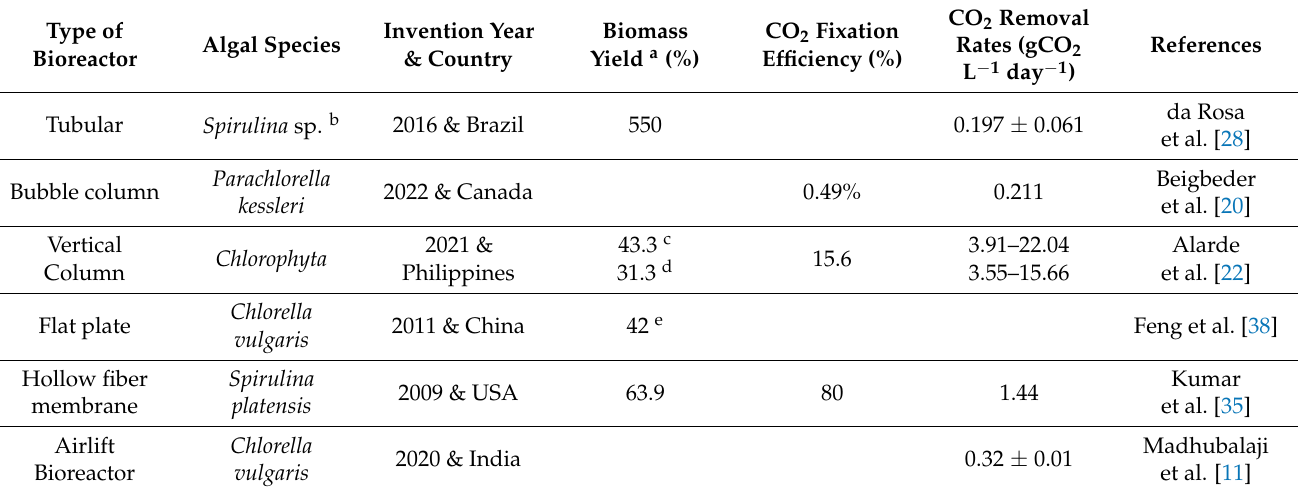
Table 2. Summary of different types of bioreactor for testing Algal species with respect to biomass yield and CO 2 fixation efficiency and removal